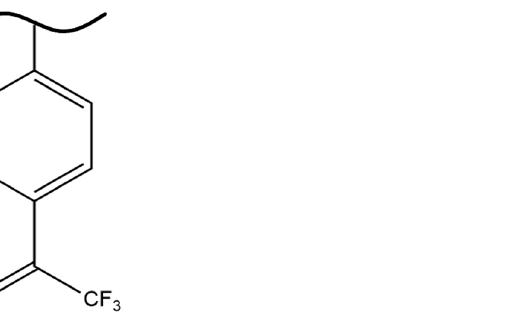
Figure 5. The chemical structure of the trifluoroacetophenone group.